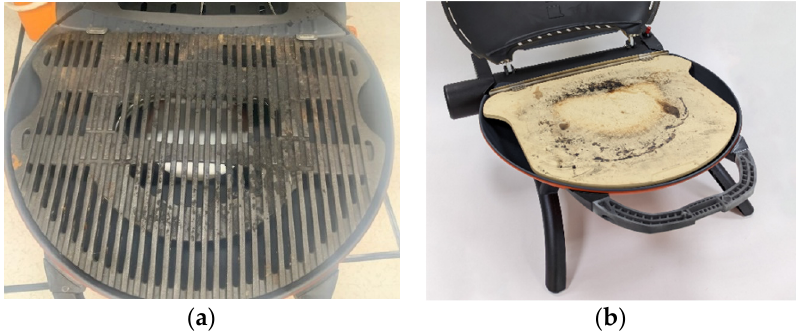
Figure 1. Mass-produced furnace structure . ( a ) iron grill pan; ( b ) stone grill plate.